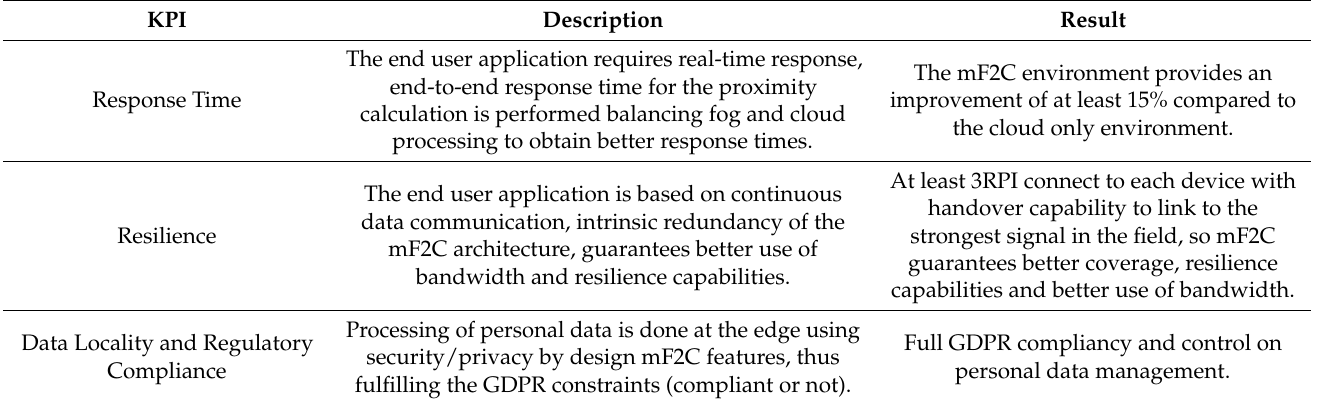
Table 4. KPIs summary for the SFHS use